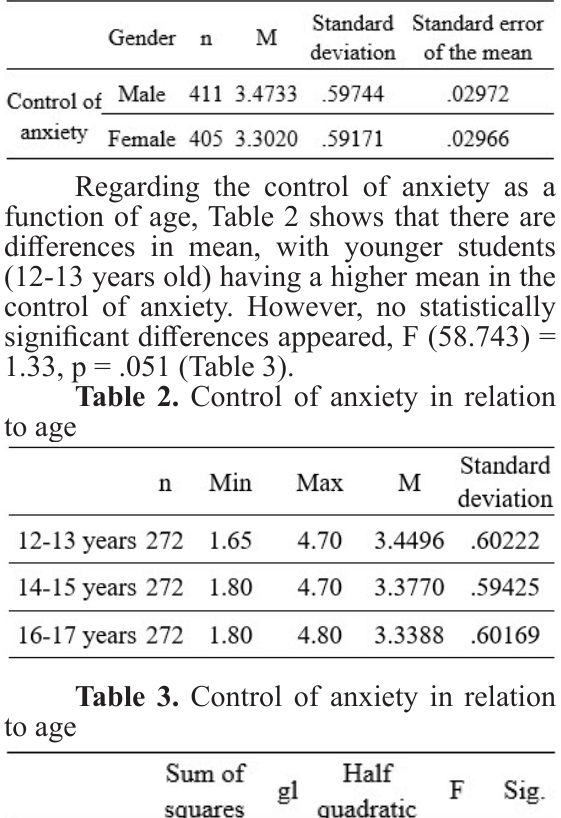
Table 1. Control of anxiety in relation